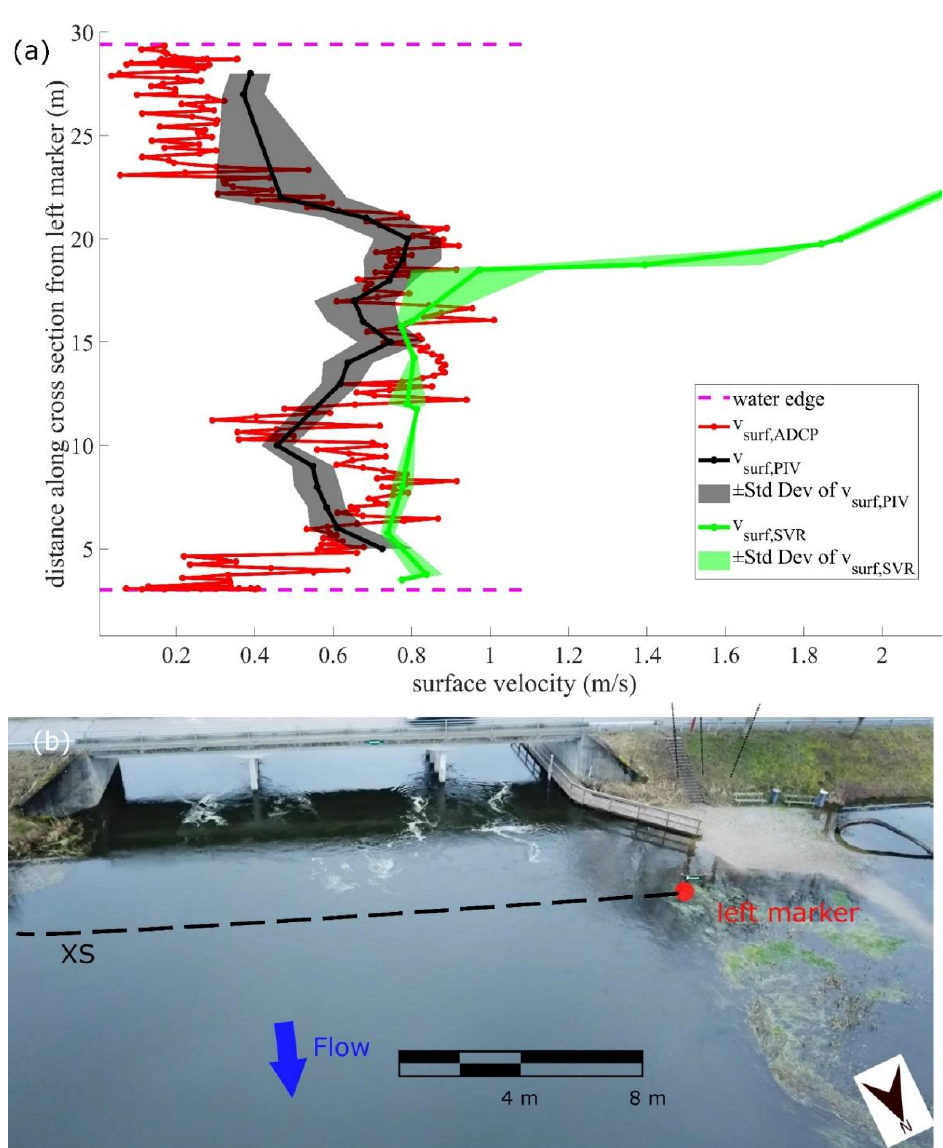
Figure 4. Guden_Svostrupvej XS (DK). ( a ) surface velocity plot comparing ADCP measurements of surface velocity (v surf,ADCP ), UAS-borne PIV (v surf,PIV ) and UAS-borne SVR (v surf,SVR ). SVR and PIV are represented with shaded grey (PIV) and shaded green (SVR) to present standard deviation ( ± Std Dev). ( b ) shows a UAS-borne video frame with also a red point indicating where the left marker was placed (North arrow, approximate flow direction and approximate scale are also